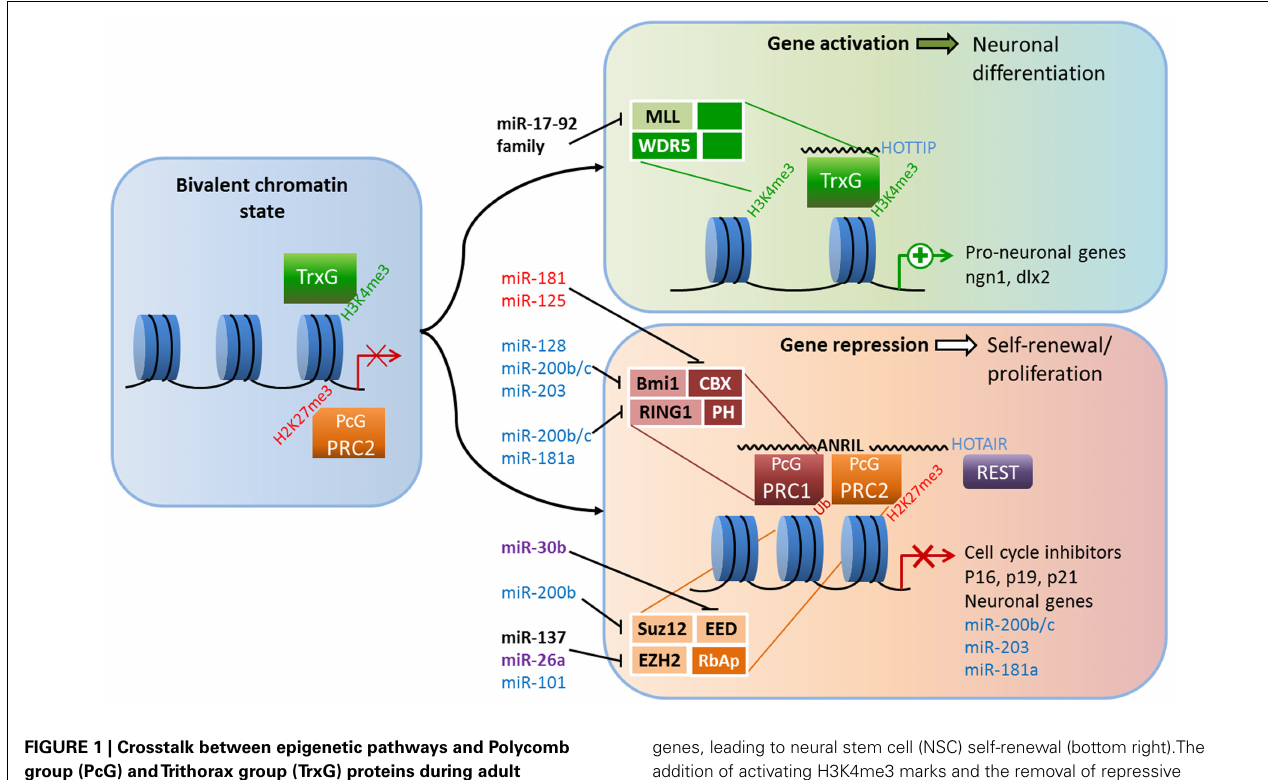
FIGURE 1 | Crosstalk between epigenetic pathways and Polycomb group (PcG) andTrithorax group (TrxG) proteins during adult neurogenesis. The figure illustrates a possible model of crosstalk between epigenetic pathways and PcG andTrxG protein complexes during adult neurogenesis. In the bivalent chromatin state, genes are poised for either rapid induction or further repression; activating H3K4me3 marks and repressing H2K27me3 marks are both present, as are the antagonisticTrxG and PcG complexes (left panel).TrxG and other activating complexes displace PRC2 and loosen the chromatin which enables the expression of neuronal genes (top right panel). Conversely, the recruitment of PRC1 and other repressive complexes (possibly REST) condenses chromatin and suppresses cell-cycle inhibitors and neuronal